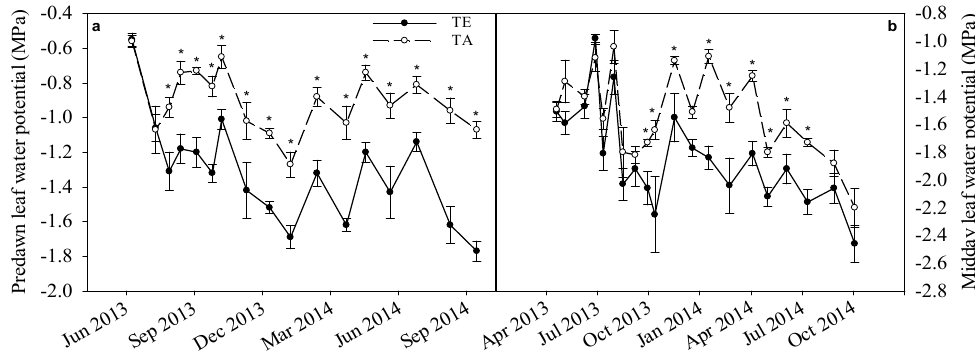
Figure 7. ( a ) Mean predawn leaf water potential and ( b ) mean midday leaf water potential in response to 100% throughfall exclusion (TE) and ambient throughfall (TA) treatments. An asterisk (*) above the data represents dates that TE effect is significant. Error bars represent standard error of treatment means ( n = 5).